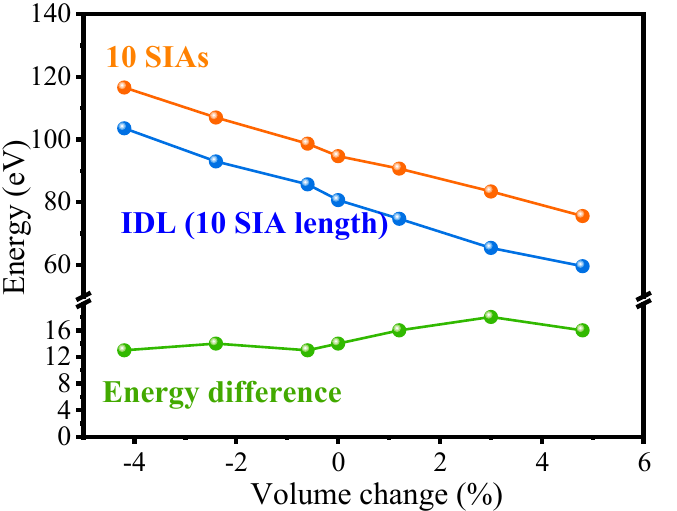
Figure 6. The 10 SIA defect and IDL (10 SIA) cluster formation energy as a function of the different strain levels.